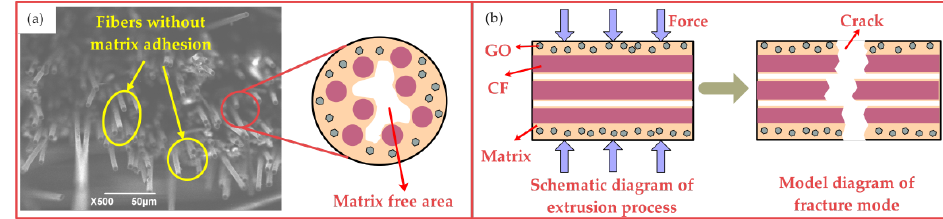
Figure 9. Fracture microstructure and mechanism of GO-CF/EP composite (30 °C): ( a ) fracture microstructure, ( b ) fracture mechanism.